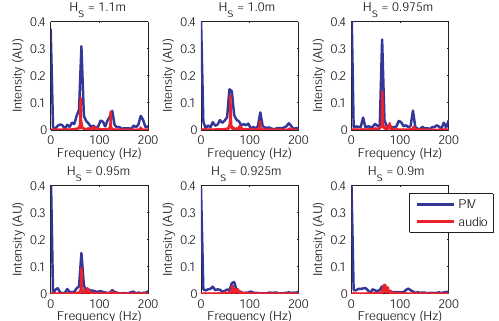
Figure 4. Comparison between the frequency of slip-stick parti- cle motion and recorded audio, for ballotini particles in a perspex tube. The data was collected when the free surface of the sand moved from H s = 1.1m to H s = 0.9m, while the camera was lo- cated at H c = H s − 0 . 05 m : the higher harmonics cut out first, and all sound and slip-stick motion ceases below 0.9m.